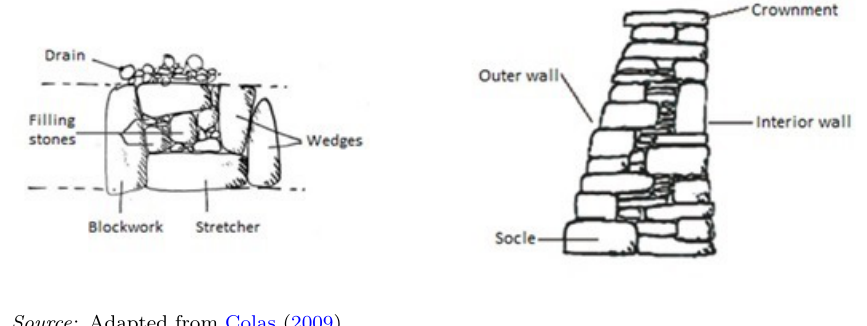
Figure 5: Building techniques. Left: Top view at the middle phase of a dry stone wall construction; Right: Cut view of a support wall